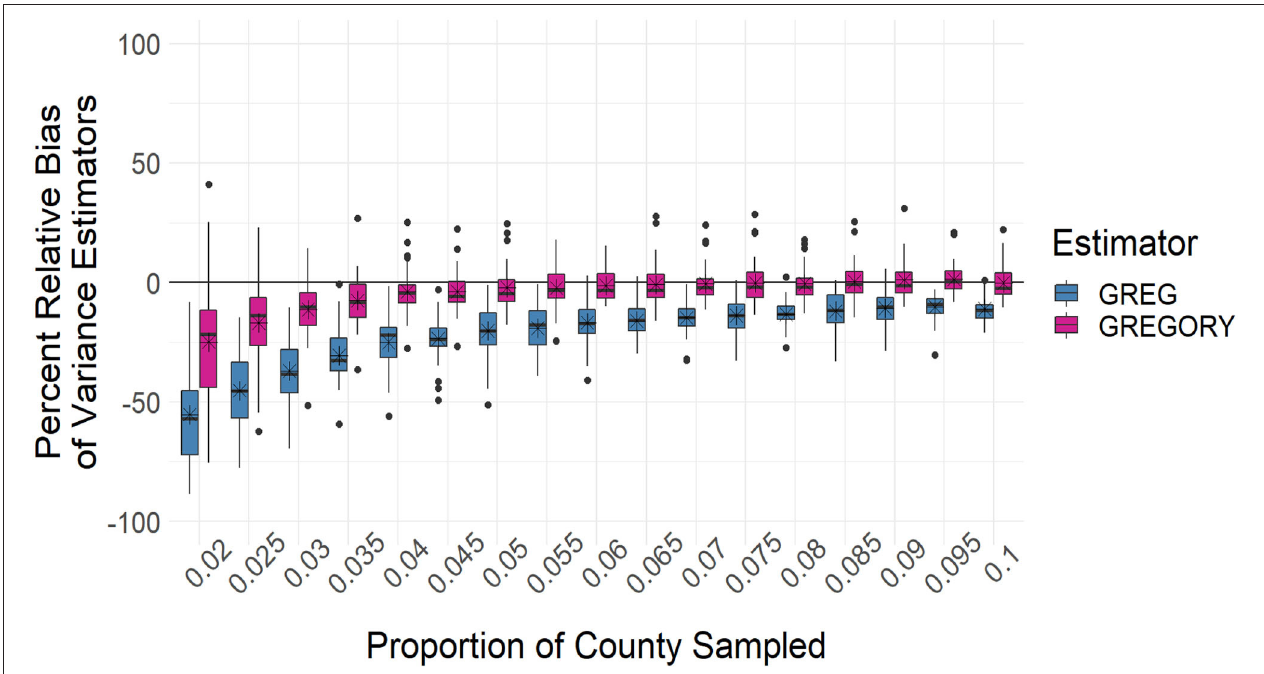
FIGURE 10 | Boxplots of the percent relative bias of the standard variance estimator when estimating the average trees per acre across the sampling intensities. The average percent relative bias is denoted by the